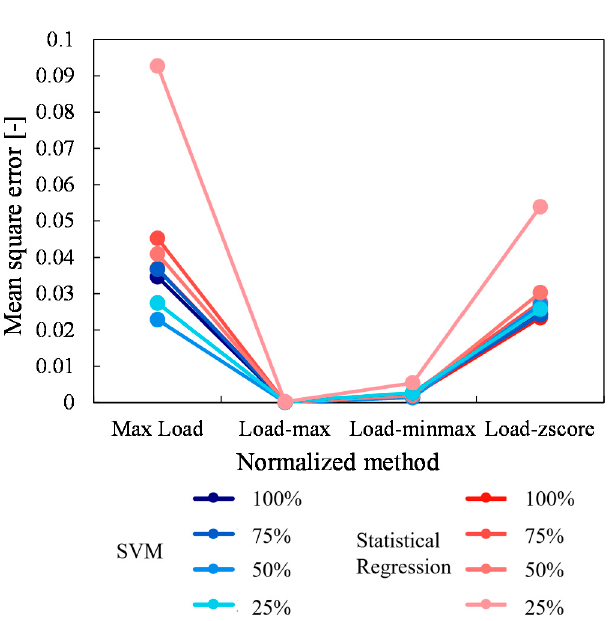
Figure 14. Comparison of mean square error for test data with SVM and statistical regression data.